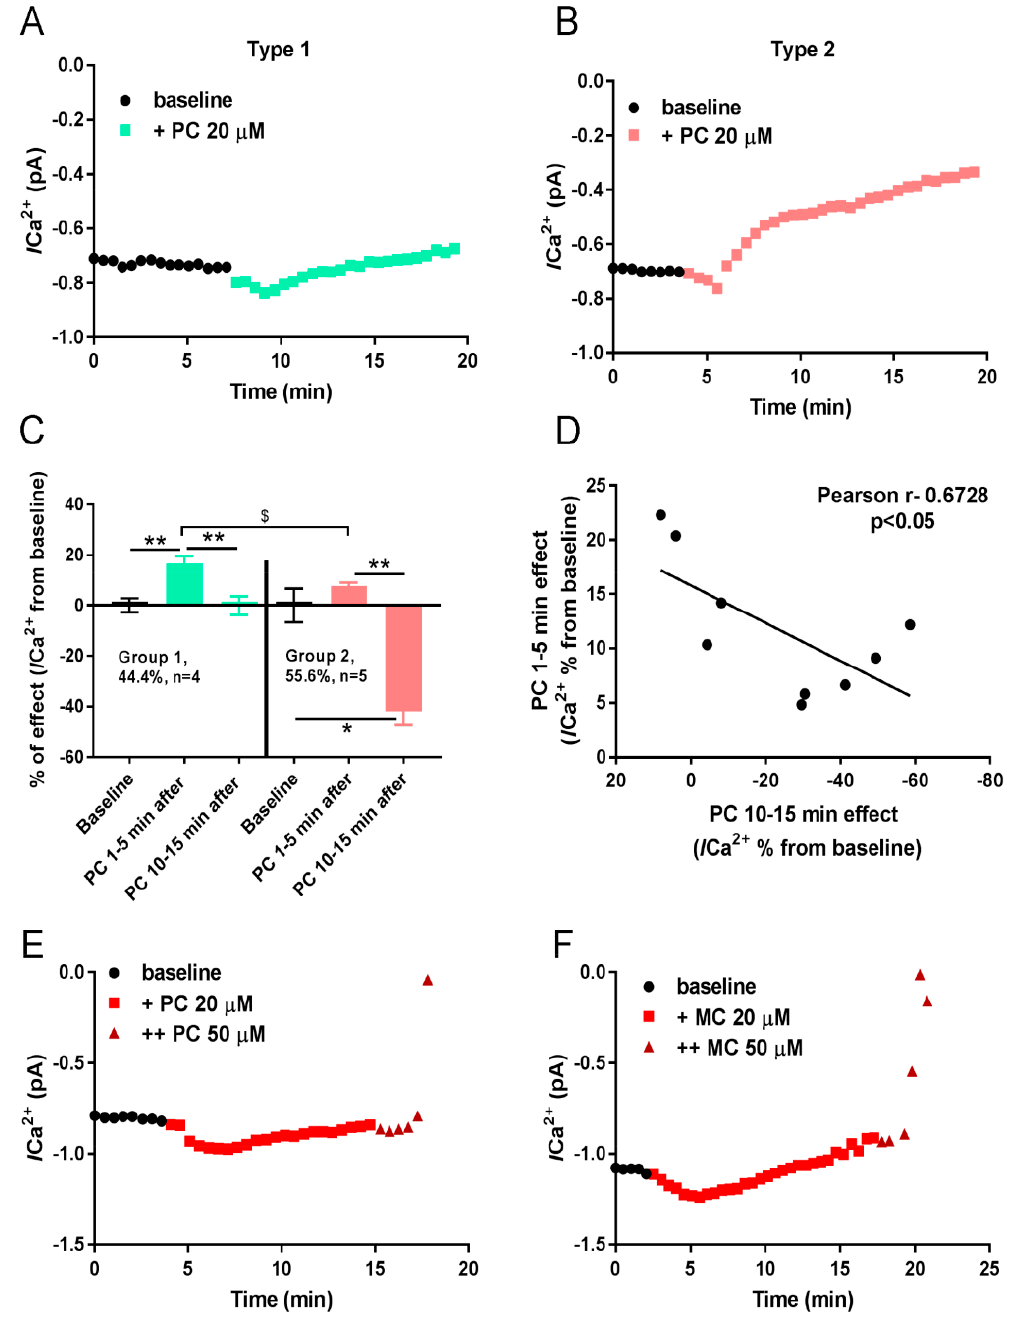
Figure 3. PC exerts multiple effects on peak Ica 2+ current in ventricular cardiomyocytes. ( A ) and ( B ). Representative time-courses of peak Ica 2+ current showing that cardiomyocytes can be separated into two types based on their response to PC. Type 1 ( A ) where PC exerts transient potentiating effect on Ica 2+ , and type 2 ( B ) where PC exerts bidirectional effect: first activating and then inhibiting Ica 2+ . ( C ). Graph bars showing summary of statistical analysis for PC action on Ica 2+ in two groups of cardiomyocytes. ( D ). Correlation of the level of initial activation of Ica 2+ with the level of subsequent inhibition in response to PC. ** p < 0.05 with ANOVA post hoc Bonferroni test. P < 0.01 with Student’s t test, r—Pearson correlation coefficient. ( E ) and ( F ). Application of 50 µM PC or MC resulted in Ica 2+ “rundown” accompanied by hypercontracture and CM death (brown triangles). Displayed graphs are representative of 3 independent